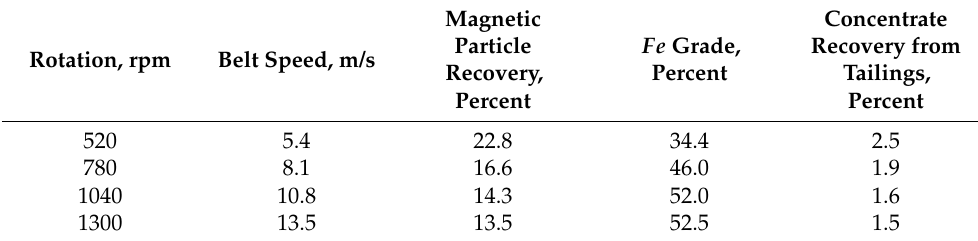
Table 5. Fine size processing